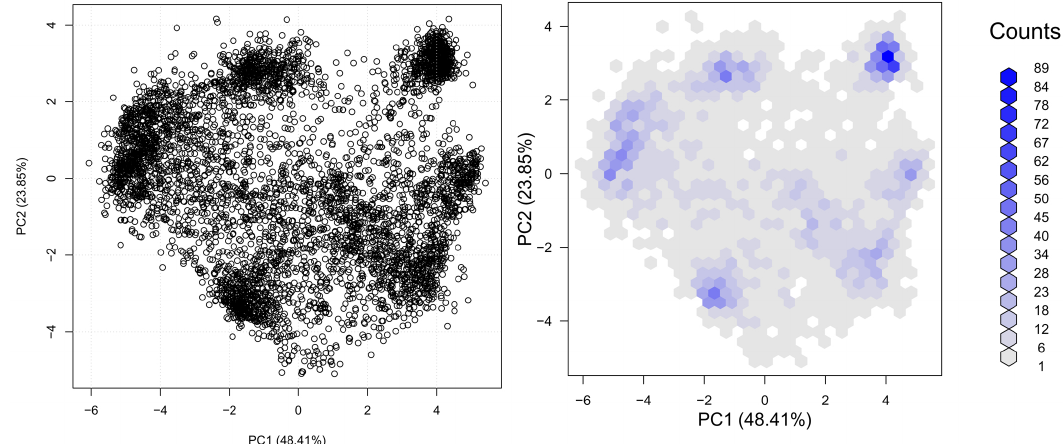
Figure 5. PCA plot of the mouse stem cell data hl . Each dot represents a single protein, and cluster of proteins represent proteins residing in the same sub-cellular niche. The figure on the right bins proteins and represent the bins density to highlight the presence of protein